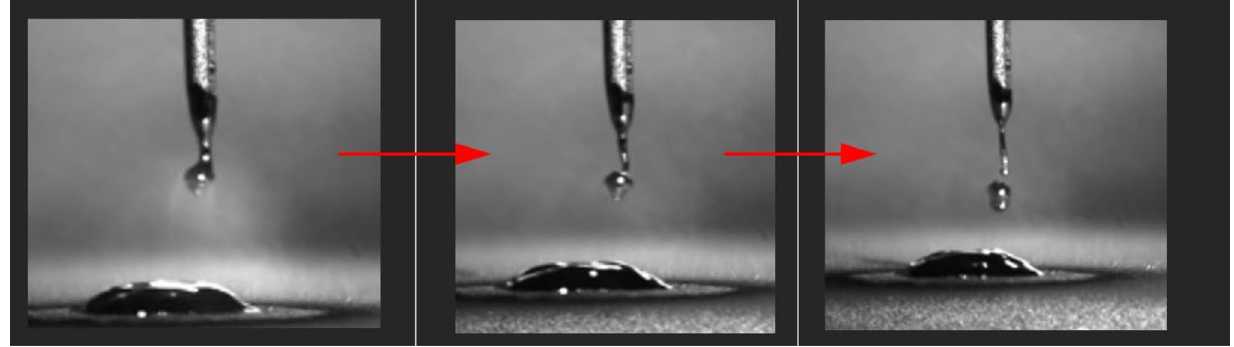
Fig. 6 Typical droplet detachment imbalance. Image data are gained in the